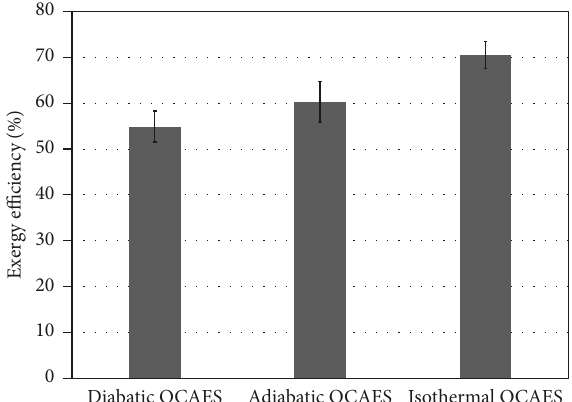
Figure 8: Overall exergy efficiency of different types of OCAES.